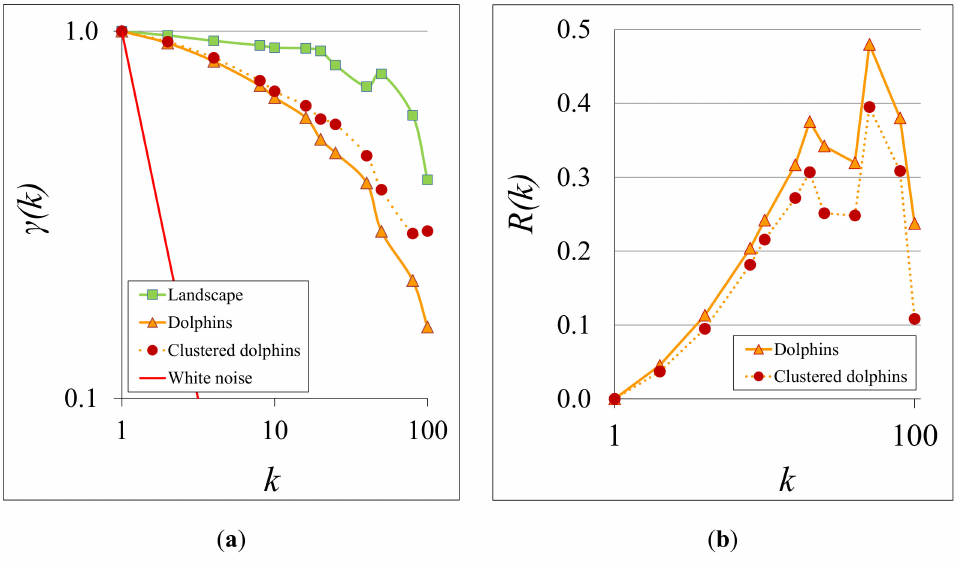
Figure 3. ( a ) Standardized climacograms of images in Figure 2 and ( b ) evaluation climacograms of original vs. transformed